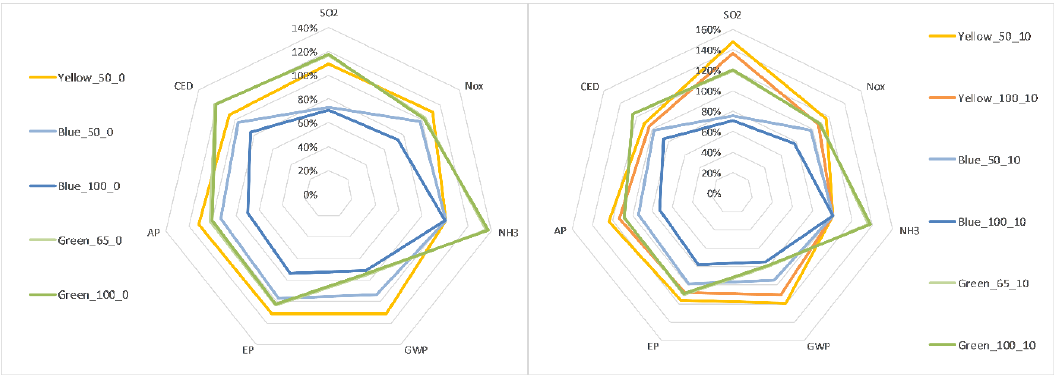
Figure 5. Environmental impacts from electricity generation in comparison to Yellow_100_0. Source: Own calculation.